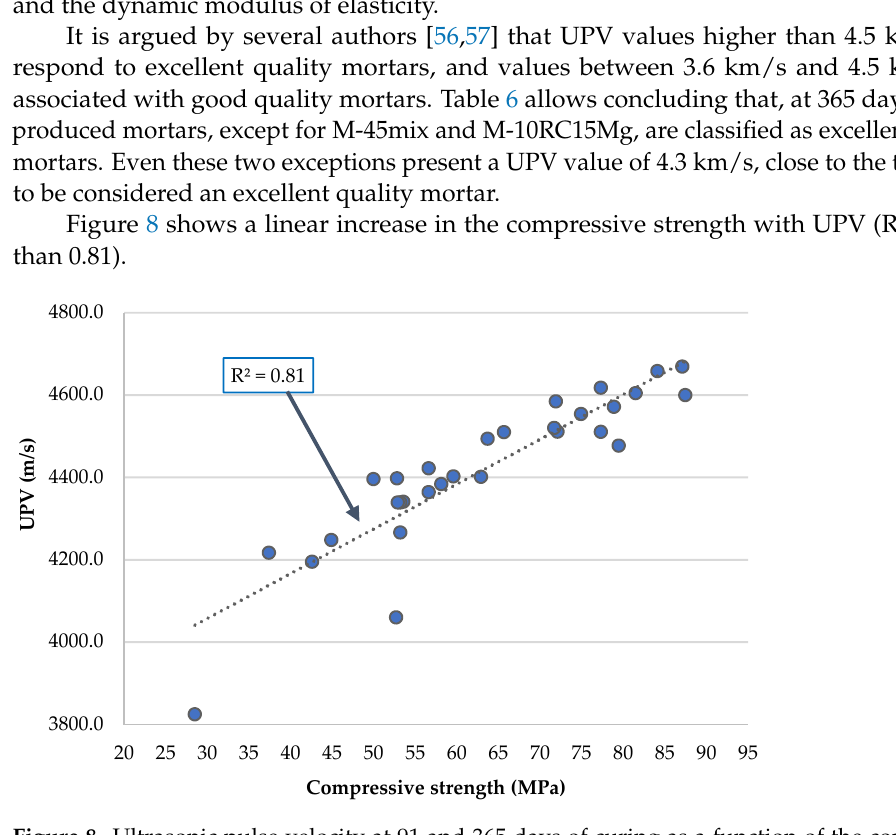
Table 10. Values used to calculate the energy consumed.